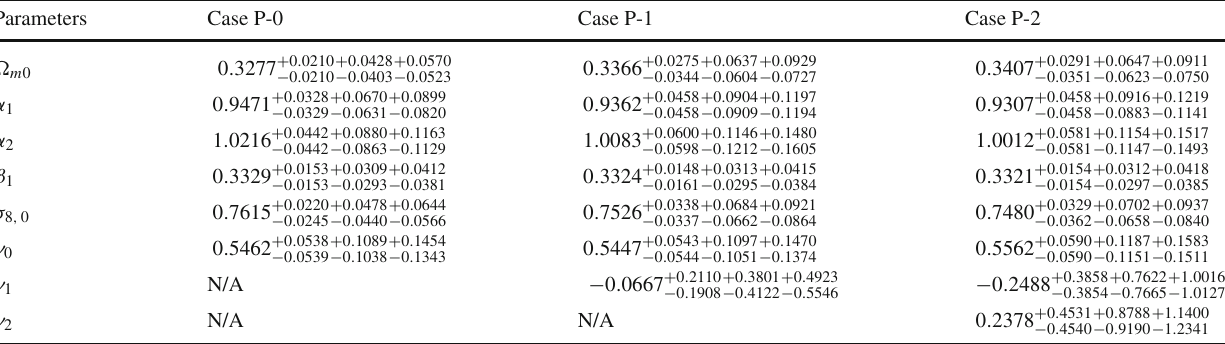
Table 4 The mean with 1 σ , 2 σ , 3 σ marginalized uncertainties of the model parameters for the cases with the Padé cosmography and γ = γ 0 (labeled as “P-0”), γ = γ 0 + γ 1 z (labeled as “P-1”), γ = γ 0 + γ 1 z + γ 2 z 2 (labeled as “P-2”). See the text for details Parameters Case P-0 Case